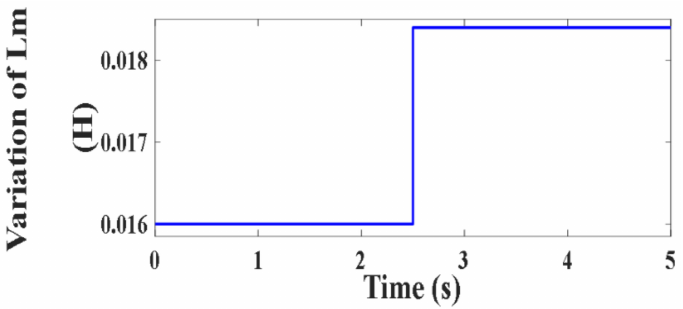
Figure 120. Variation of L m